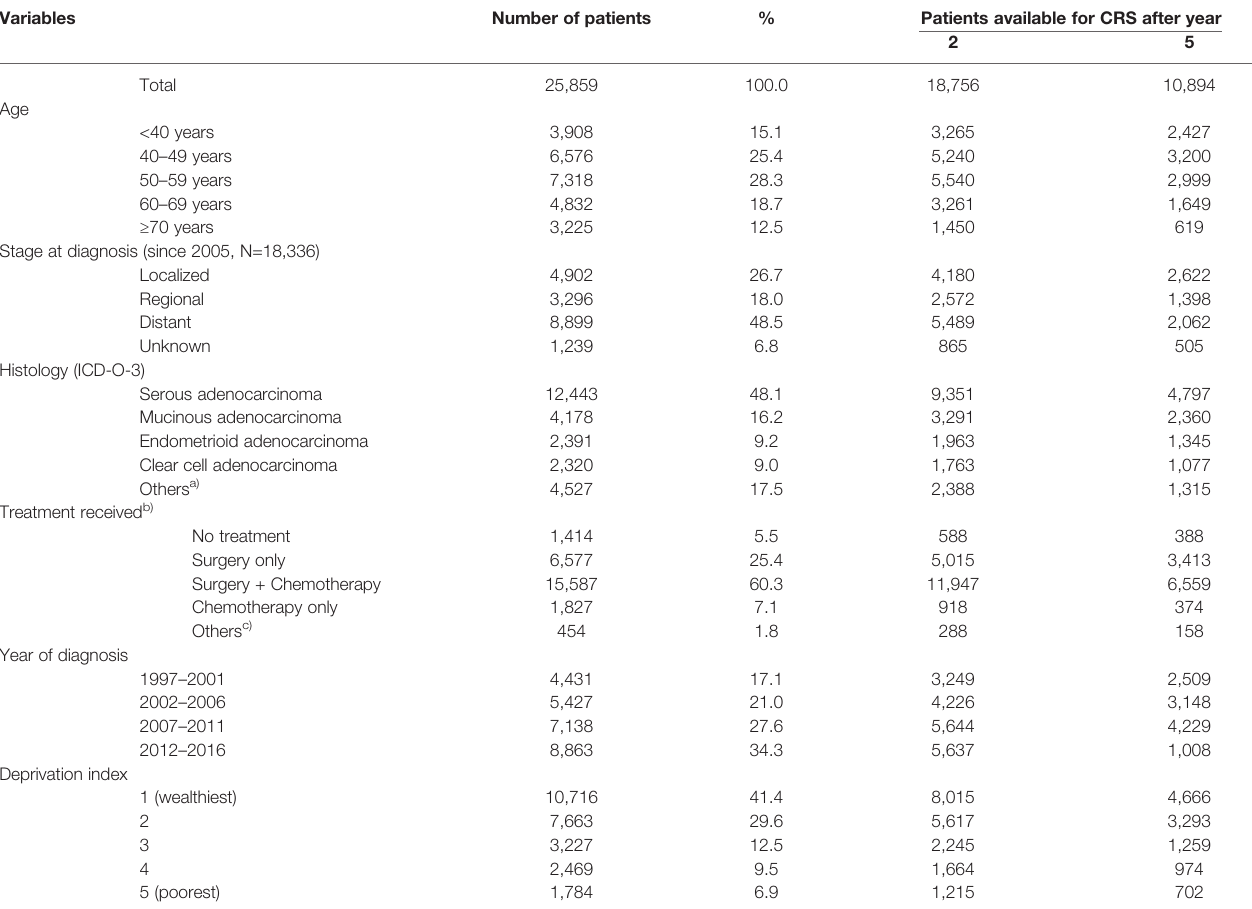
TABLE 1 | Baseline characteristics of Korean ovarian cancer patients, 1997 –